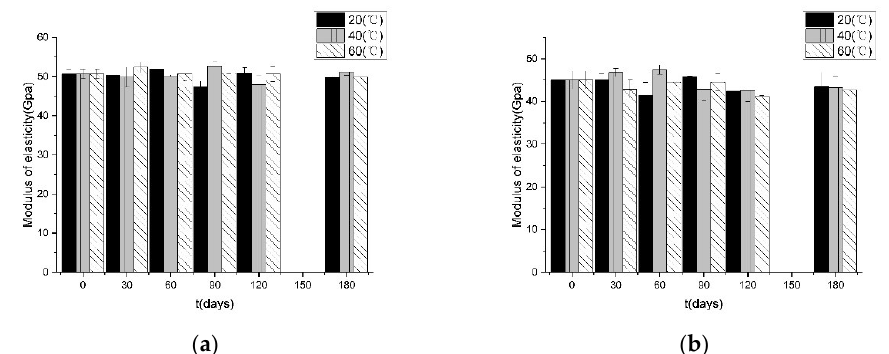
Figure 6. Modulus of elasticity of GFRP bars after accelerated aging: ( a ) G1; ( b ) G2. The tensile strength retention ( T re ) was calculated as the percentage of the tensile strength of the GFRP bars after conditioning over that of the unconditioned ones, as shown in Figure 7. The tensile strength of both G1 and G2 decreased with increased exposure time at all exposure temperatures. For aging at 20 °C, the degradation rate of both G1 and G2 decreased after 120 days. For aging at 40 °C, the degradation rate of both G1 and G2 varied li(cid:308)le. For aging at 60 °C, the degradation rate of G1 decreased significantly after 60 days, while the degradation rate of G2 decreased significantly after 30 and 120 days. The degradation rate decreased as the exposure time increased, and the tensile strength retentions tended to converge to a constant value with increased exposure time. As the exposure temperature increased, the degradation rate increased. This was mainly ide ion increased as the temperature increased. For aging at 20, 40 °C and 60 °C, there was li(cid:308)le difference in the residual tensile strength between the two types of GFRP bars after different exposure times, except 60 days at 60 °C, when G2 had a higher tensile strength retention than G1 (shown in Figure 8). It should be emphasized that after 180 days (the longest exposure time), the residual tensile strength of the two types of GFRP bars was similar.